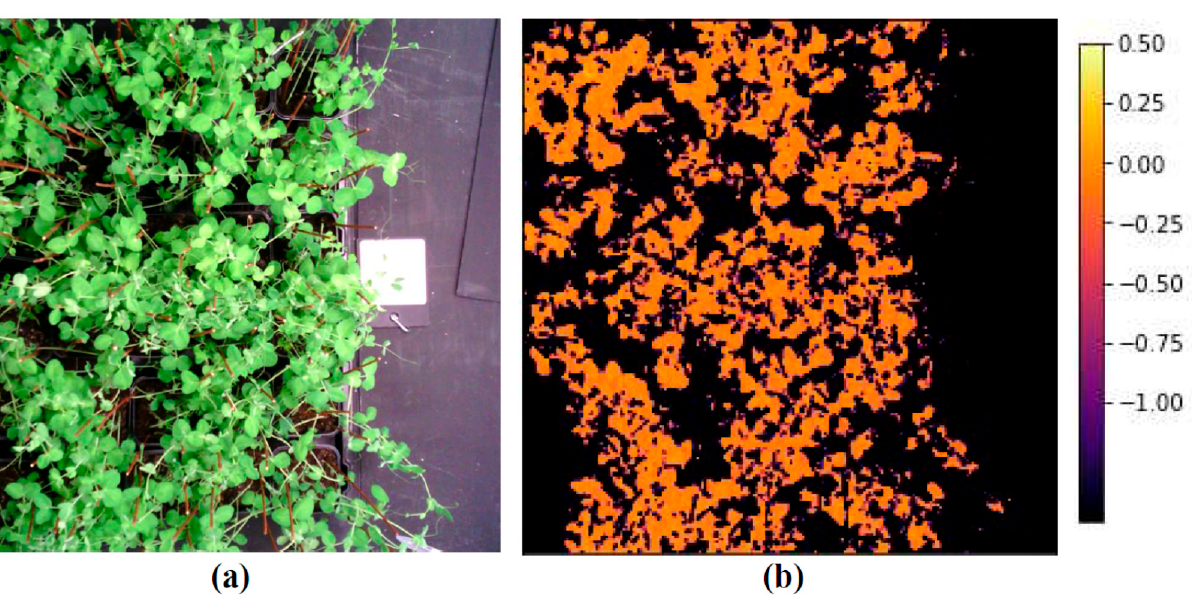
Figure 1. Examples of RGB image and pseudocolor RI image after excluding background. ( a ) RGB image of pea plants; ( b ) pseudocolor image of RI (670, 432) of pea plants; ( c ) RGB image of wheat plants; ( d ) pseudocolor image of RI (670, 432) of wheat plants. Plants cultivated in the vegetation room and measured at 90° angle to the ground plane (“View from above”) are shown. Table 1 shows the directions of drought-induced changes in these 46 RIs (decrease or increase) in comparison to control values of the same RIs (in plants with irrigation) which were observed in the current work. Only significant differences between RIs in plants under drought conditions and control plants were analyzed. It should be noted that the magnitudes of these changes increased with the increase of the duration of the soil drought. The duration of the soil drought, which was necessary for the initiation of these changes, was not analyzed at this stage of the investigation. It was shown that the most of investigated RIs in pea plants under soil drought were significantly changed in comparison to the values of these RIs in irrigated plants. There were different directions of these changes in different plants, under different conditions of plant cultivation, or at different angles of measurement. The result was contradictory to our previous work [38], which showed an increase in all investigated RIs under the short-term water shortage. It was also shown that some RIs were significantly changed in wheat plants under soil drought (Table 1). Some of these RIs were decreased, while other RIs were increased under the soil drought. It was important to note that directions of changes in RIs often differed in pea and wheat plants.